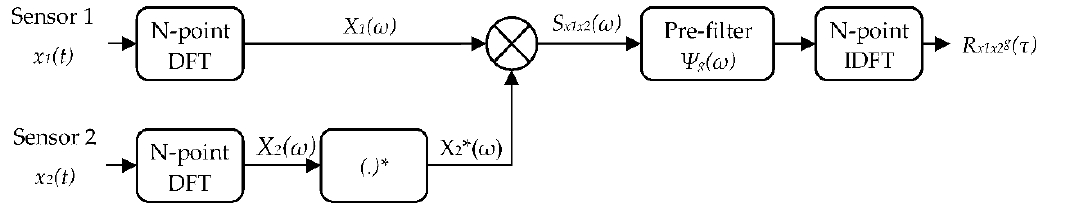
Figure 2. Schematic of the implementation of the modified GCC location method.